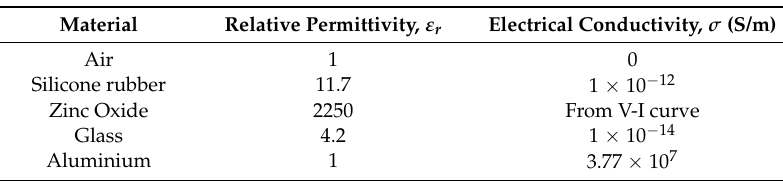
Table 3. Properties of each material in the model.